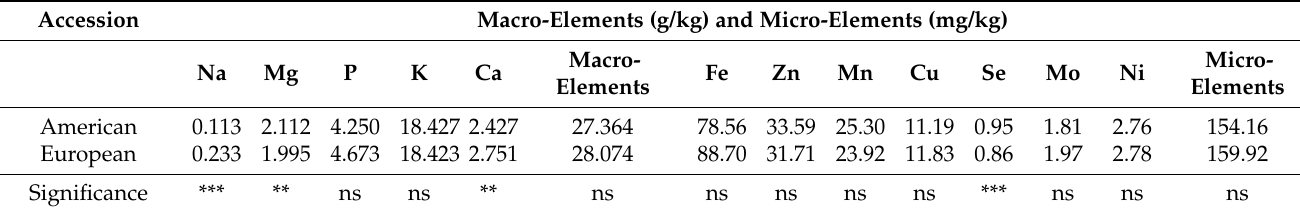
Table 5. Analysis of covariance for the mean micro-elements and macro-elements for the American and European accessions.